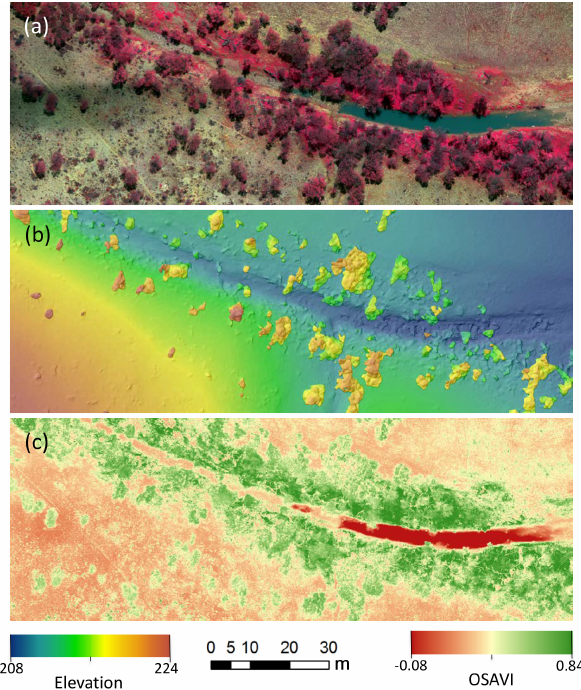
Figure 3. Employing a UAV to retrieve high-resolution multispec- tral information on the land surface for hydrology and related appli- cations over an Australian rangeland site located near Fowler’s Gap in New South Wales. Retrieved products include (a) a false-colour infrared image, (b) a reconstructed digital surface model using vis- ible imagery and structure-from-motion techniques and (c) an op- timized soil adjusted vegetation index (OSAVI) derived from the 4-band multispectral image. Images were captured using a MicaS- ense/Parrot Sequoia sensor on-board a 3DR Solo quadcopter. The UAV was flying at a height of 40m, providing a ground sampling distance of approximately 3cm. Imagery provided by the University of Tasmania’s TerraLuma Research